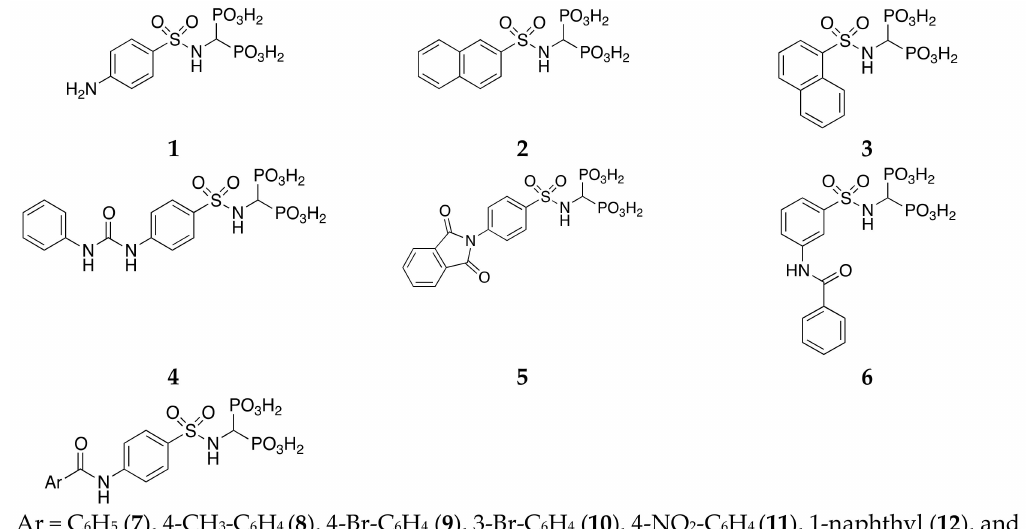
Figure 4. Chemical structures of compounds 1–13